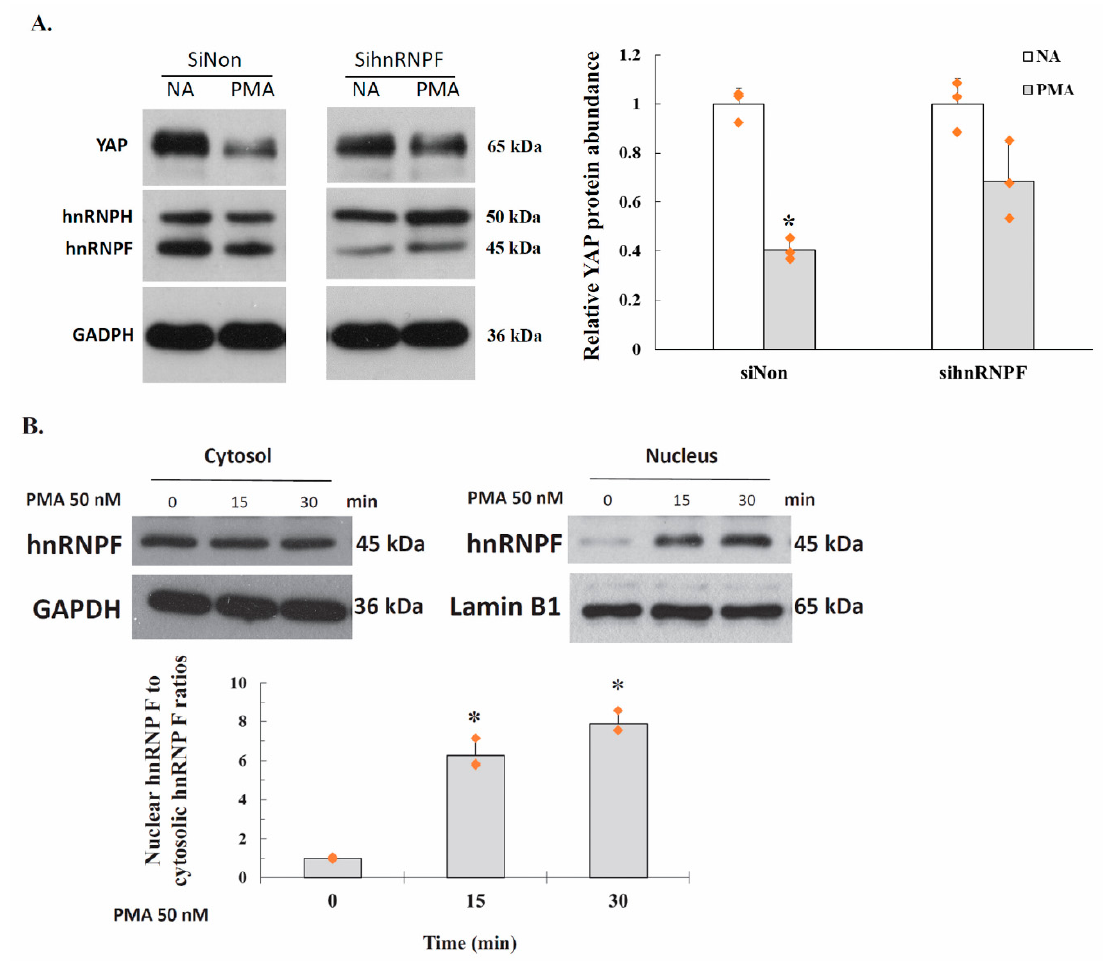
Figure 4. Knockdown of hnRNP F prevents the down-regulation of YAP expression by activated PKC and PKC activation enhances increased hnRNP F nuclear translocation. ( A ). PC-3 cells were transfected with siNon or sihnRNPF (40 nM each) for 24 h ( n = 3). The cells were then incubated with 50 nM PMA. Cell lysates were prepared 24 h after treatment, and were subjected to Western blot analysis with anti-YAP, anti-hnRNP F/H and anti-GAPDH antibodies. Significance is tested using two-tailed Student’s t -test, where * denotes p < 0.05 compared to the same siRNA transfected cells not treated with PMA. ( B ). PC-3 cells were treated with 50 nM PMA for 24 h ( n = 3). Cell lysates were prepared, and fractionated into cytosolic and nuclear fractions. The fractions were analyzed by immunoblot using anti-hnRNP F. anti-GAPDH and anti-Lamin B1 were used as cytosolic and nuclear loading controls. Fold changes are represented as relative values of band densities normalized to the control. Significance was tested using one-way analysis of variance (ANOVA) with Holm–Sidak method post hoc test, where * p < 0.05 compared to the untreated cells.